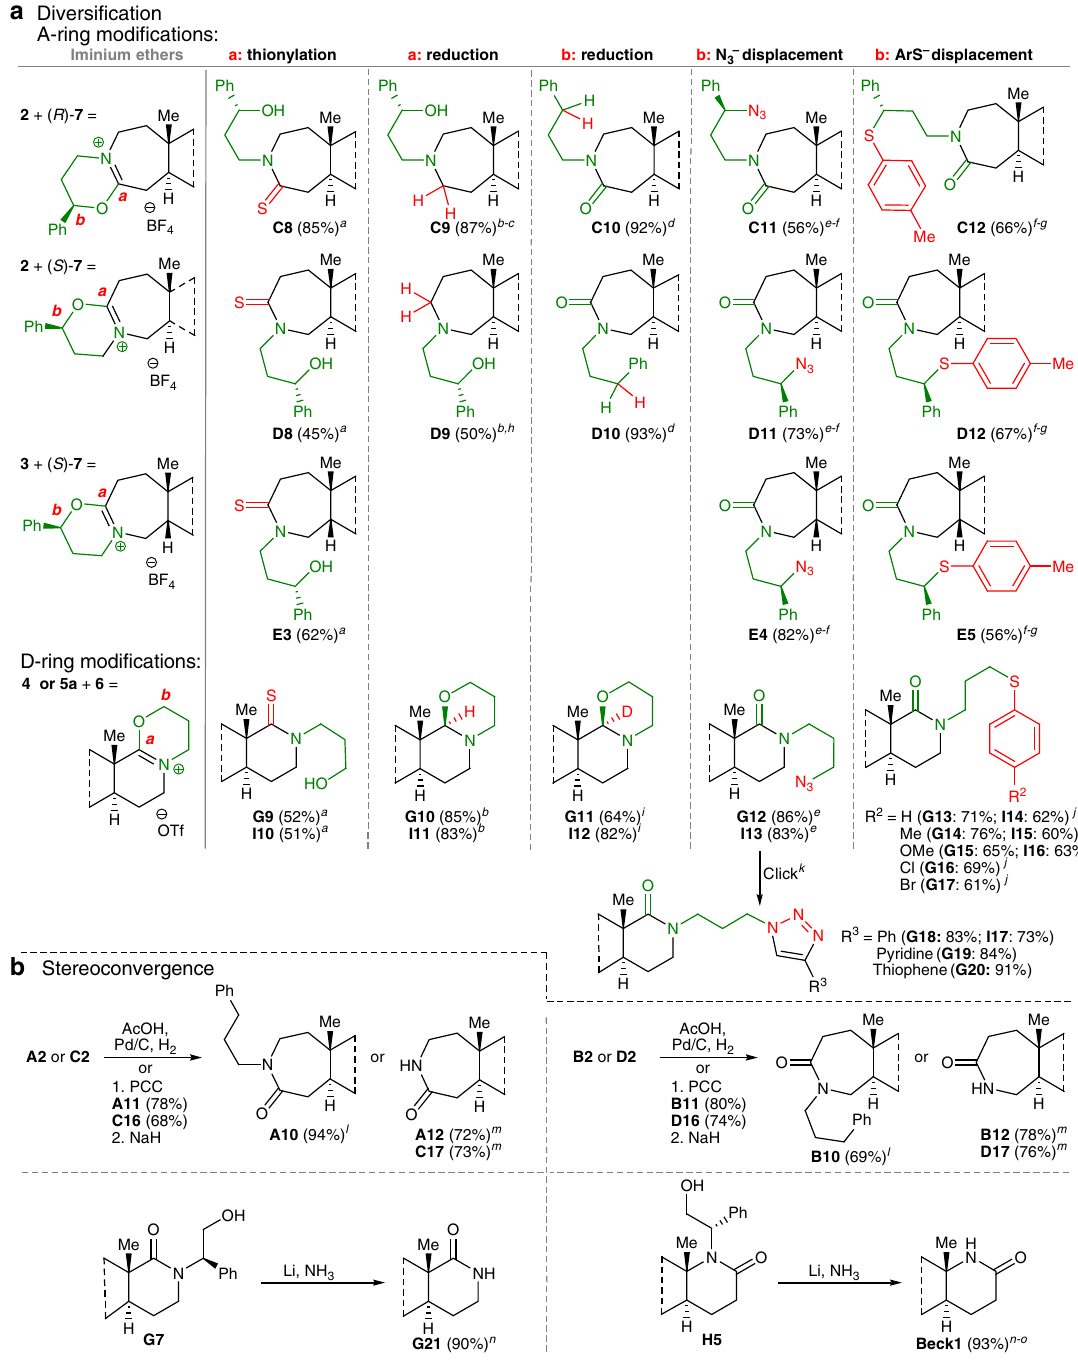
Fig. 4 Structural diversi fi cation. a Diversi fi cation of iminium ethers for A-ring and D-ring iminium ether intermediates. Green text highlights the azide component and red text highlights the nucleophile component; positions a and b (in red) mark the sites of particular transformations. Yields refer to isolated yields of products after chromatography on silica. b Stereoconvergence and synthesis of parent NH lactams. Yields refer to isolated yields of products after chromatography on silica. a Na 2 S, THF or DMF, 65 °C. b NaBH 4 , MeOH, rt. c C9 was also obtained following LAH reduction of C2 (51%). d Hydrogenation using 10% Pd/C, EtOH. e NaN f Inversion of stereochemistry. g 4-Methylbenzenethiol, DMF, 75 °C. h D9 was also obtained 3 , DMF, 70 °C. following LAH reduction of D2 (58%). i NaBD 4 , MeOH, rt. j Stock solutions of sodium thiophenoxides, DMF, 75 °C. k Substituted acetylene, CuSO 4 (cid:129) 5H 2 O, sodium L -ascorbate, t BuOH/H 2 O. l Hydrogenation using 10% Pd/C, AcOH, EtOH. m Removal of non-benzylic side chain via treatment with base. n Removal of benzylic side chain via dissolving metal reduction. o Isolated product is Beck1 . See Supplementary Methods for full synthetic details. C and D are 5 α - dihydrotestosterone derivatives; E and F are 5 β -dihydrotestosterone derivatives; G are trans -androsterone derivatives; I are estrone derivatives. AcOH, acetic acid; PCC, pyridinium chlorochromate; NaH, sodium hydride in 60% mineral oil; Na 2 S, sodium sul fi de; THF, tetrahydrofuran; DMF, dimethylformamide; NaBH 4 , sodium borohydride; MeOH, methanol; EtOH, ethanol, LAH, lithium aluminum hydride in 1 M THF; NaN 3 , sodium azide; NaBD 4 , sodium borodeuteride; t BuOH, tert -butanol; H 2 O, distilled